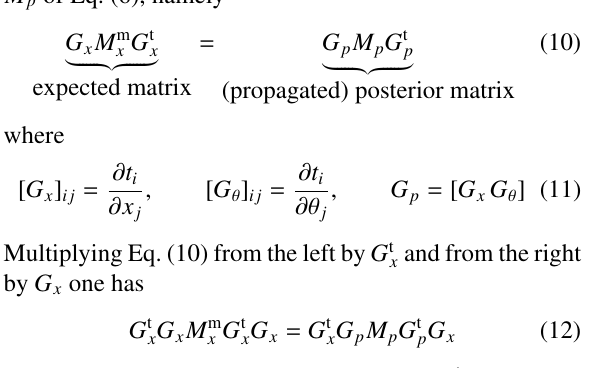
Figure 3. Uncertainty propagation in the three “matrix marginal- ization” methods: informative (top), non-informative (middle), conservative-informative